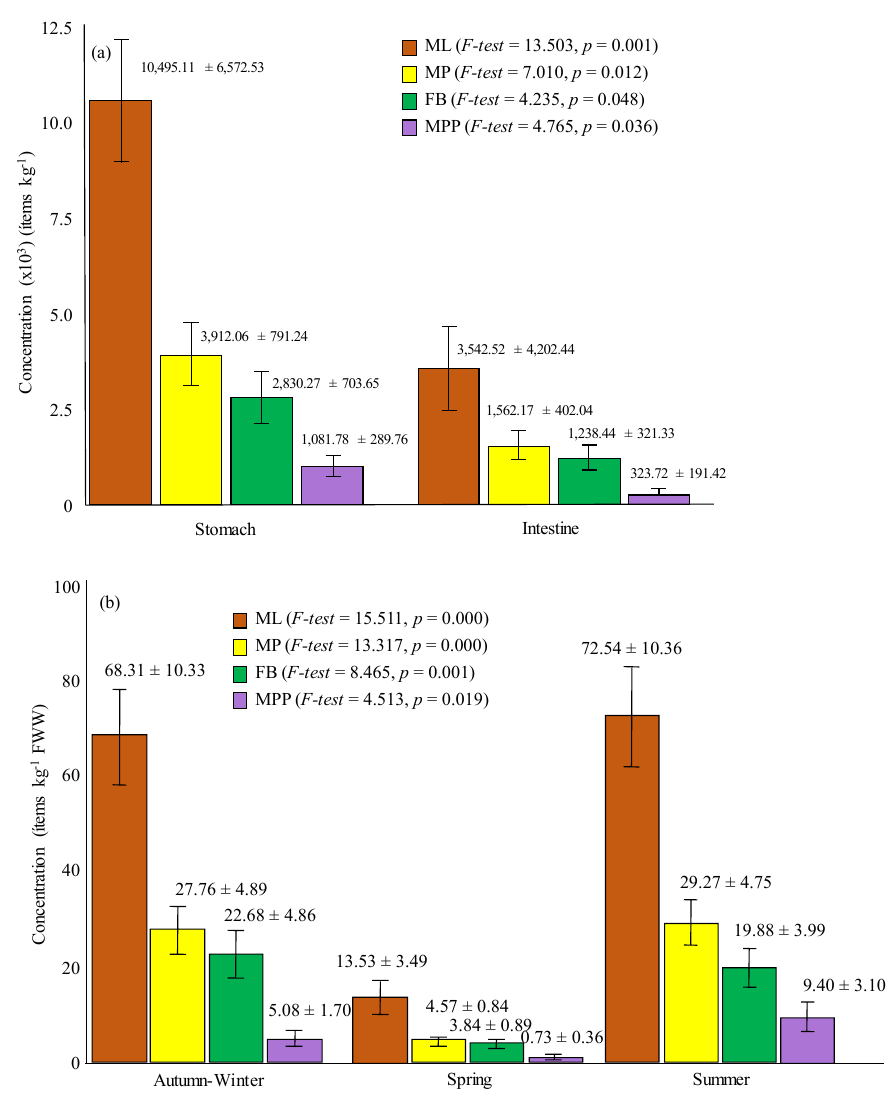
Figure 1. Average concentrations of: ( a ) microlitter (ML), microplastic (MP), fiber (FB), and particulate microplastic (MPP) in fish stomachs and intestines; ( b ) ML, MP, FB, and MPP according seasons (error bars represent standard error).